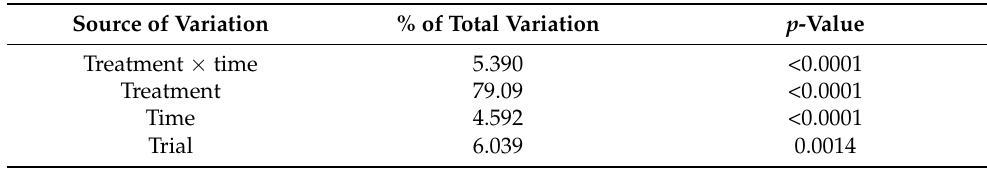
Table A1. Results of repeated measures two-way ANOVA, regarding the source of variation and contribution of row and column effects to overall data variation. The percentage of total variation caused by the respective factors is given, as well as p